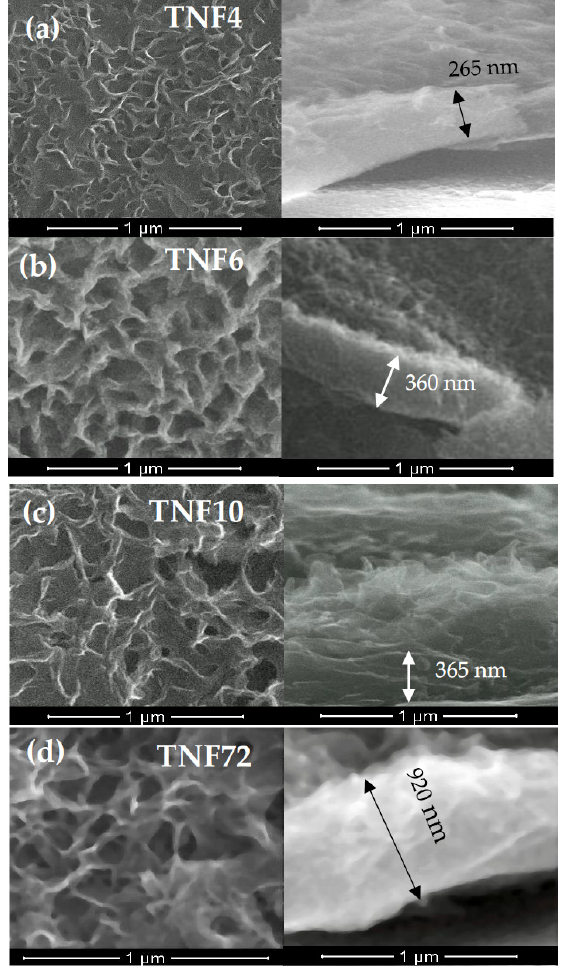
Figure 2. SEM images (top view and cross section) of the surface morphology and cross-sections of titania nanofibers (TNF) produced on the Ti6Al4V substrates: ( a ) TNF4, ( b ) TNF6, ( c ) TNF10, and ( d ) TNF72.